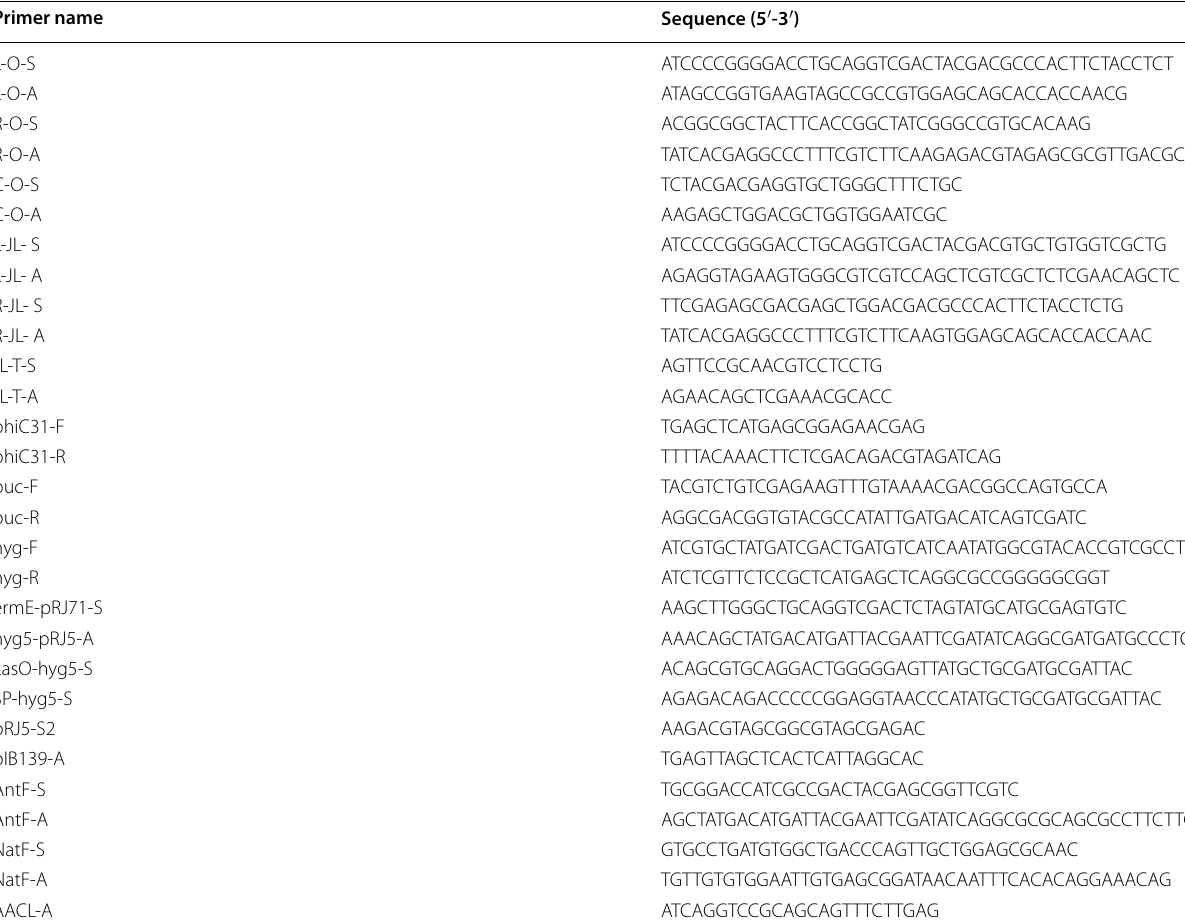
Table 1 PCR primers used in the